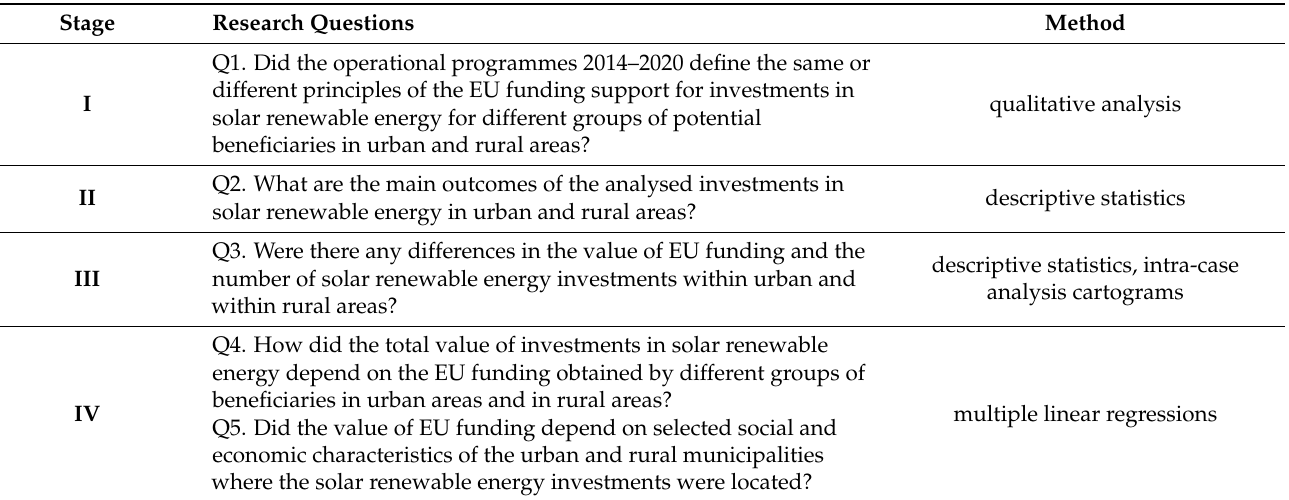
Table 2. Methodological framework.